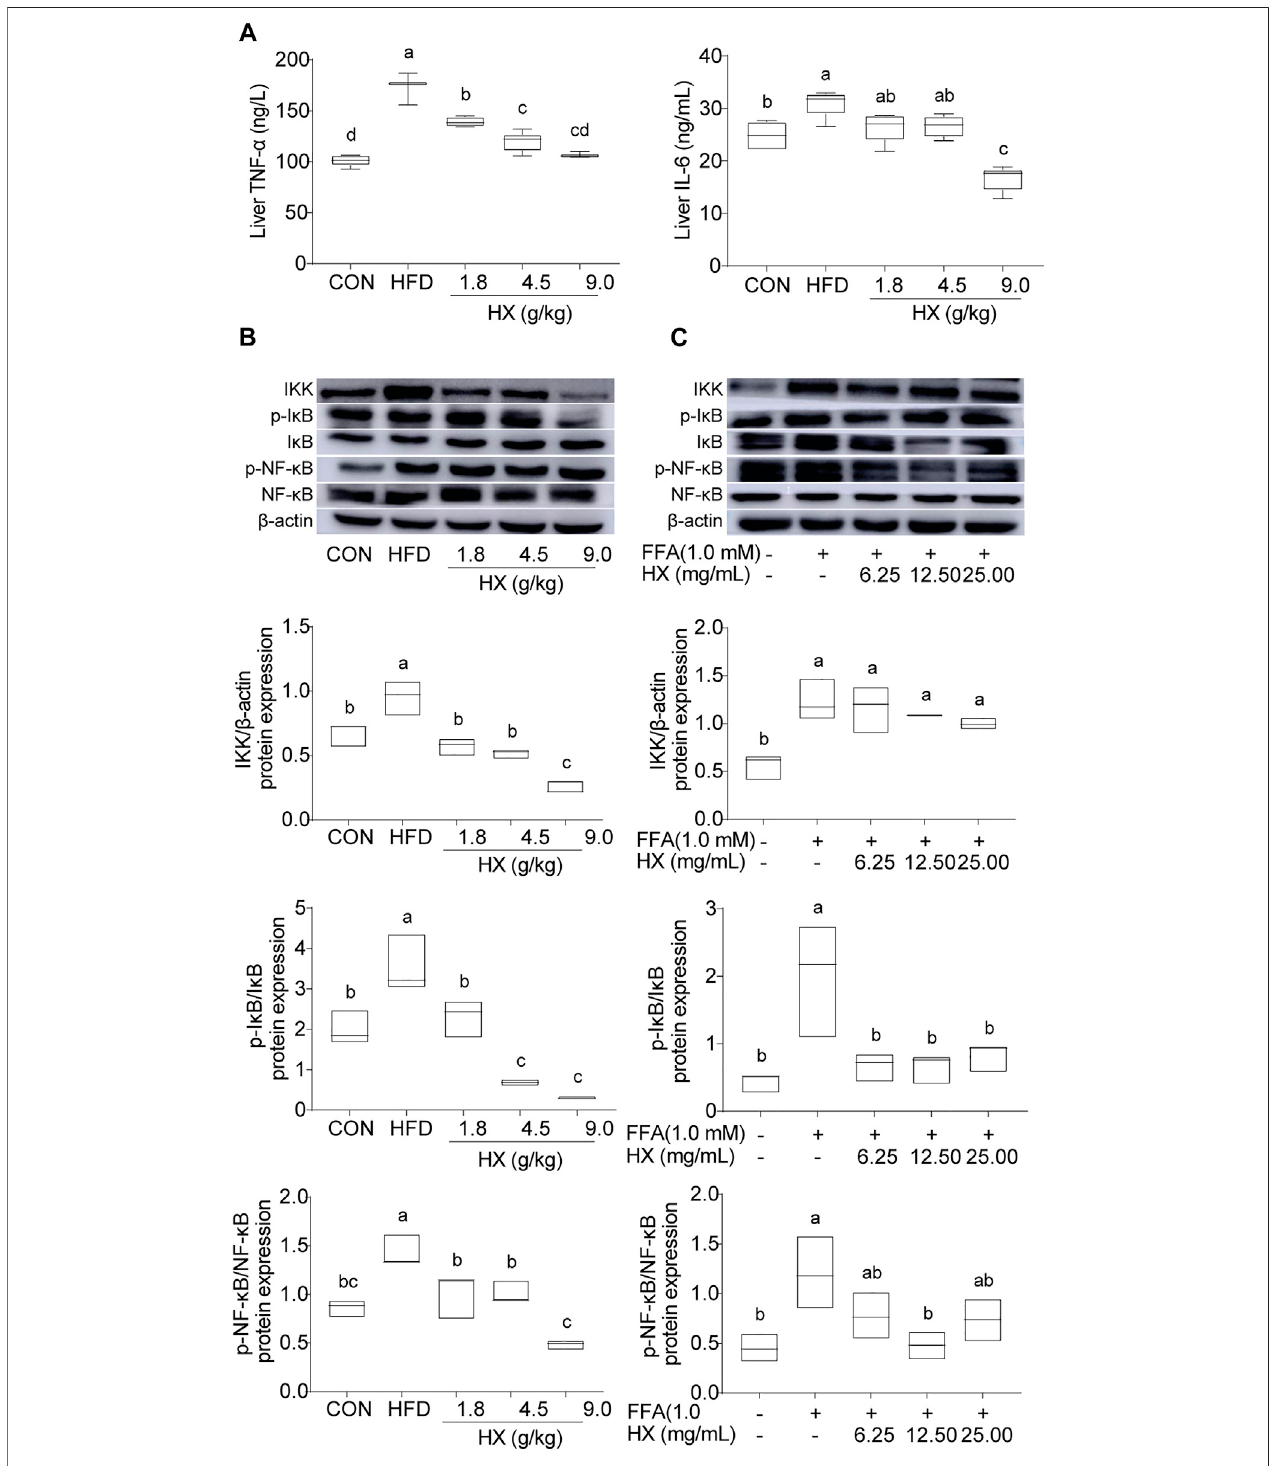
FIGURE7|(A) ConcentrationsofTNF- α andIL-6and (B) componentsofthein fl ammatorypathwayinthelivertissueofmiceafter8 weeksofHFDfeeding, (C) and in AML12 cells incubated without or with FFA and different concentrations of HX (6.25, 12.50, and 25.00 mg/ml). A one-way ANOVA was used, and multiple comparisons were employed, and the results are expressed as the mean ± SEM ( n (cid:2) 6 per group). Statistical analyses were performed using Student ’ s t test. Different lowercase letters denote signi fi cant differences among groups ( p < 0.05). TNF- α , tumor necrosis factor- α ; IL-6, interleukin-6; IKK, inhibitor of κ B kinase; NF- κ B, nuclear factor- ĸ B; I κ B, inhibitor of NF- κ B; p-I κ B, phosphorylation inhibitor of NF- κ B; p-NF- κ B, phosphorylation nuclear factor- ĸ B; CON, control; HFD, high-fat diet; HX, Huo Xiang.